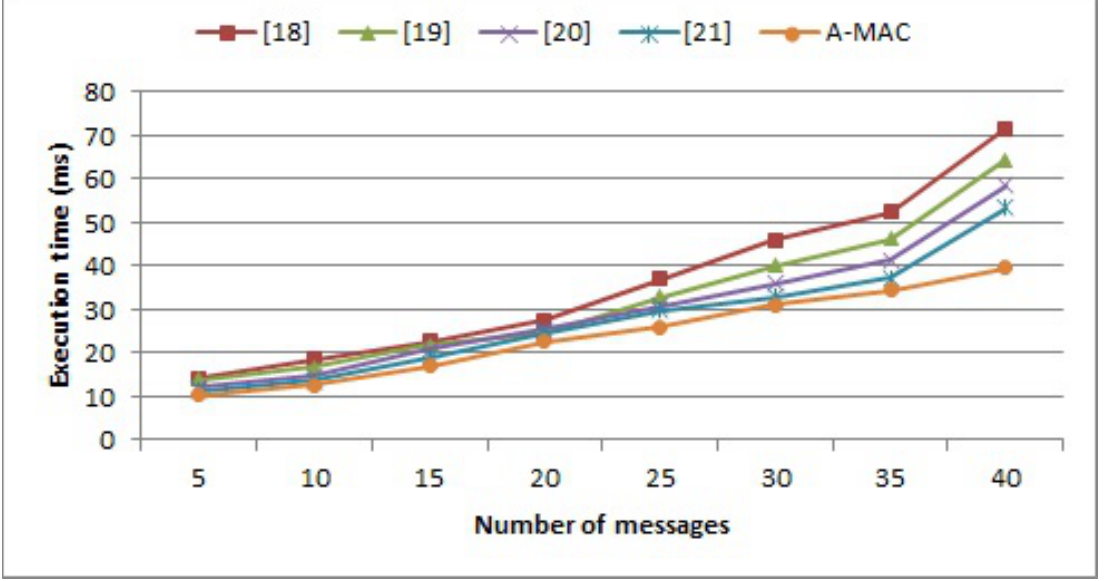
Figure 7. Execution time.